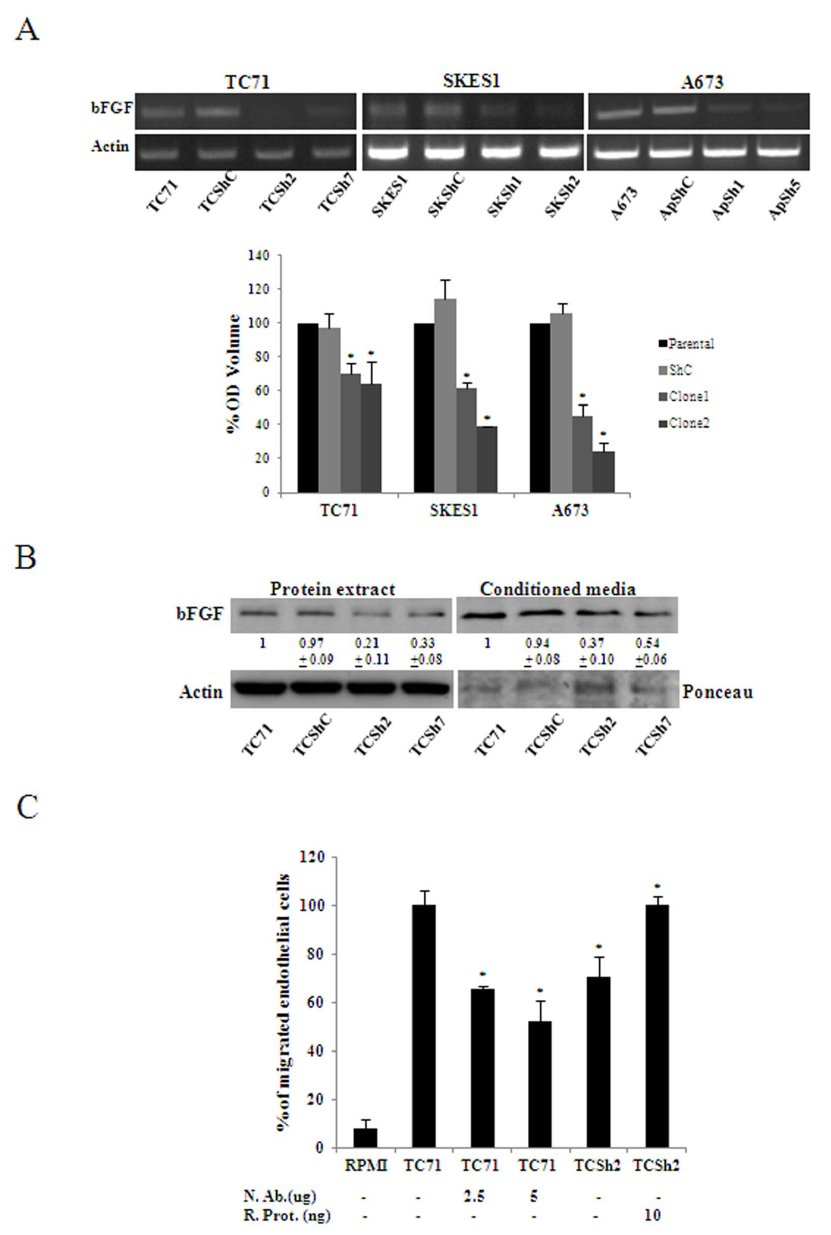
Figure 3. CAV1 silencing results in reduced bFGF transcription and secretion. A. bFGF expression was analyzed in CAV1 knocked-down models showing that bFGF expression was affected constantly in all models. The graph shows the quantification of the OD volume determined from the intensity of the bands from the RT-PCR images showing the statistically significant reduction in bFGF in CAV1 knocked-down cells; bars, SD (*P # 0.05 n=3) B. Immunoblot showing bFGF reduction in the TC71 model either in total protein extract or CM. Actin blot and ponceau staining was used as loading control. Quantitative data measuring relative intensity of the bands is indicated below each lane (n=3) C. Quantification of endothelial cell migration. CM was used as chemoattractant for endothelial cells. A neutralizing antibody -N. Ab- (2.5 m g/ml and 5 m g/ml) and a recombinant protein -R. Prot- (10 ng/ml); bars, SD (*P , 0.002– when compared with parental CM – and *P=0.0005– when compared with clone n=3) were used to block and promote migration respectively. RPMI media alone was used as negative